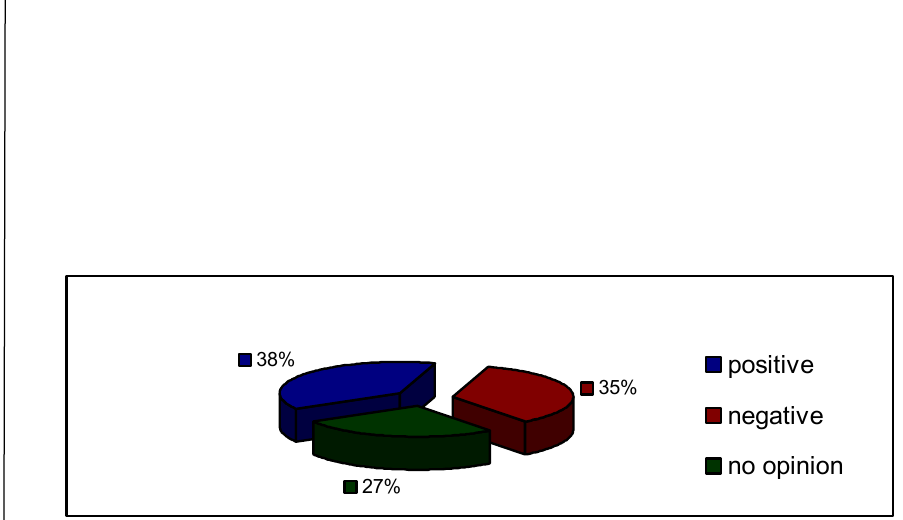
Figure 7 – Assessment of the involvement of all the responsible members of the Serbian Army in decision making Рис . 7 – Оценка участия всех ответственных лиц – служащих Вооруженных Сил Республики